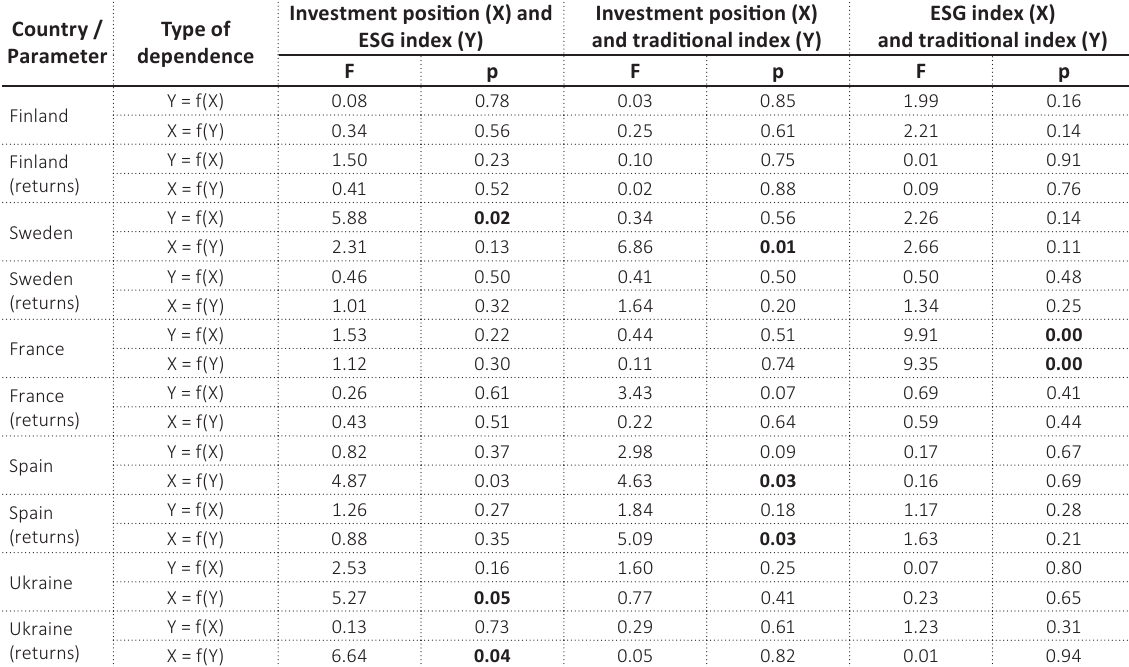
Table 6. Granger tests for countries’ investment position, ESG and traditional